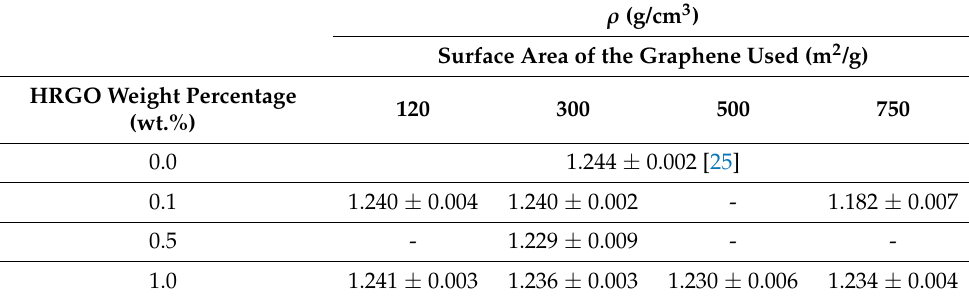
Table 4. Material density versus the percentage and surface area of the added HRGO. Each result shows the mean value and root mean square error.